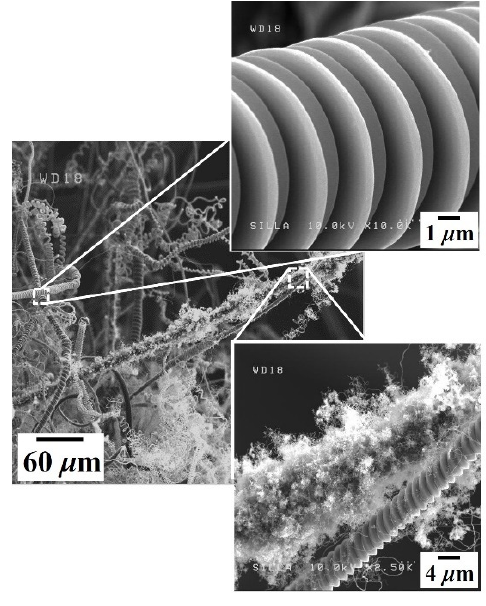
Figure 7. FESEM images of sample D.